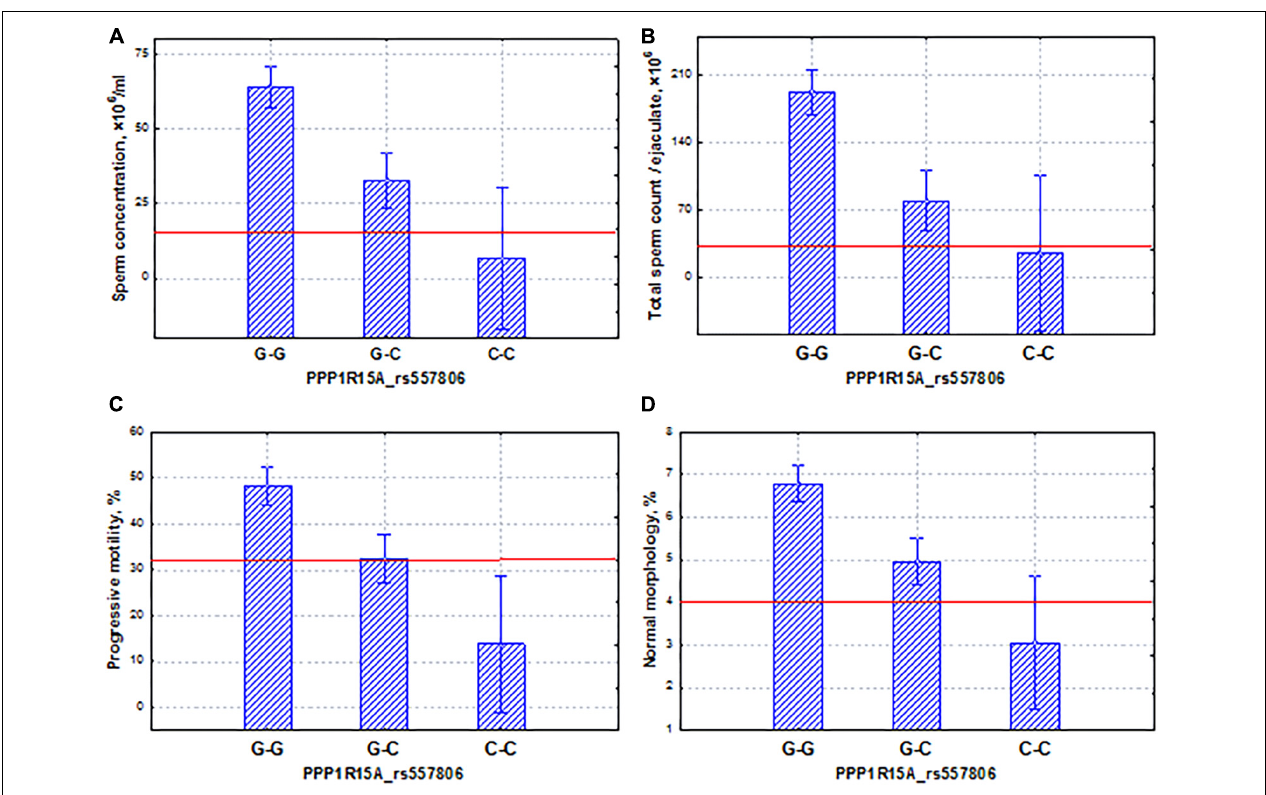
FIGURE 7 | Coordinated allelic effects of the SNP marker rs557806 of the PPP1R15A gene on semen quality parameters. (A) Sperm concentration, (B) total sperm count, and (C) proportion of motile, and (D) morphologically normal sperm. All the allelic differences were highly significant ( p < 0.005). The red lines indicate the WHO reference limits for different normal semen parameters [World Health Organization (WHO),